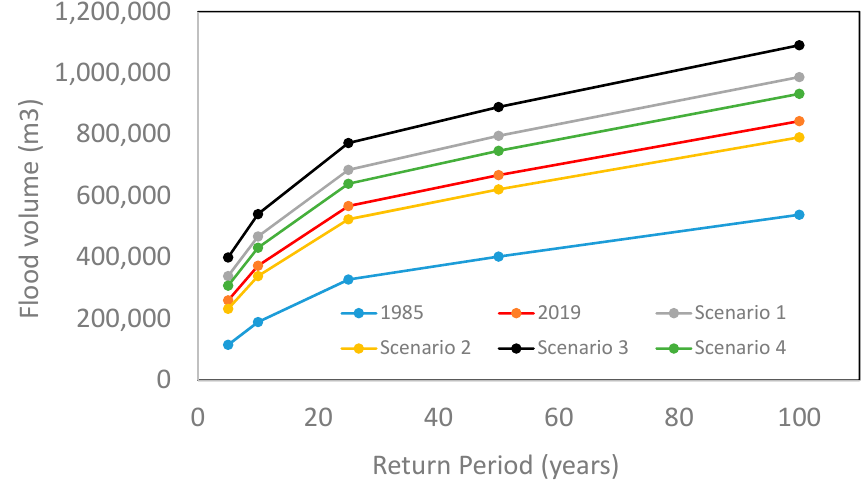
Figure 4. Design flood volume from Kakia for different LULC scenarios.